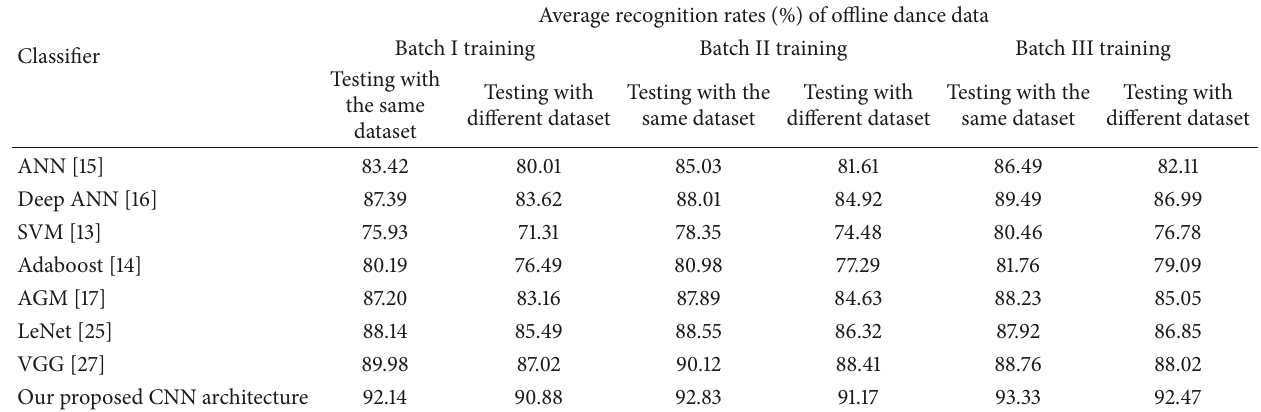
Table 4: Recognition rates of offline dance data identification with different classifiers.